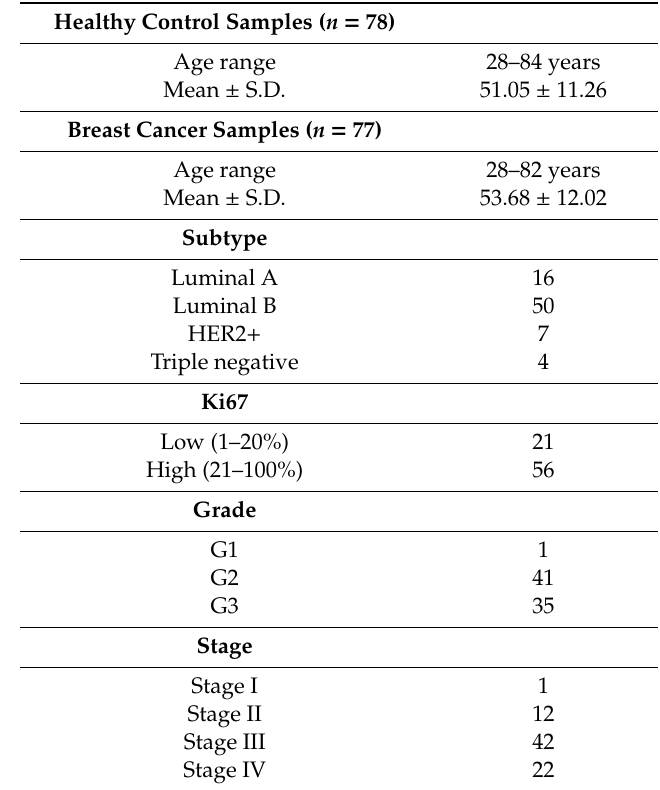
Table 1. Detailed clinicopathological characteristics of the study participants.